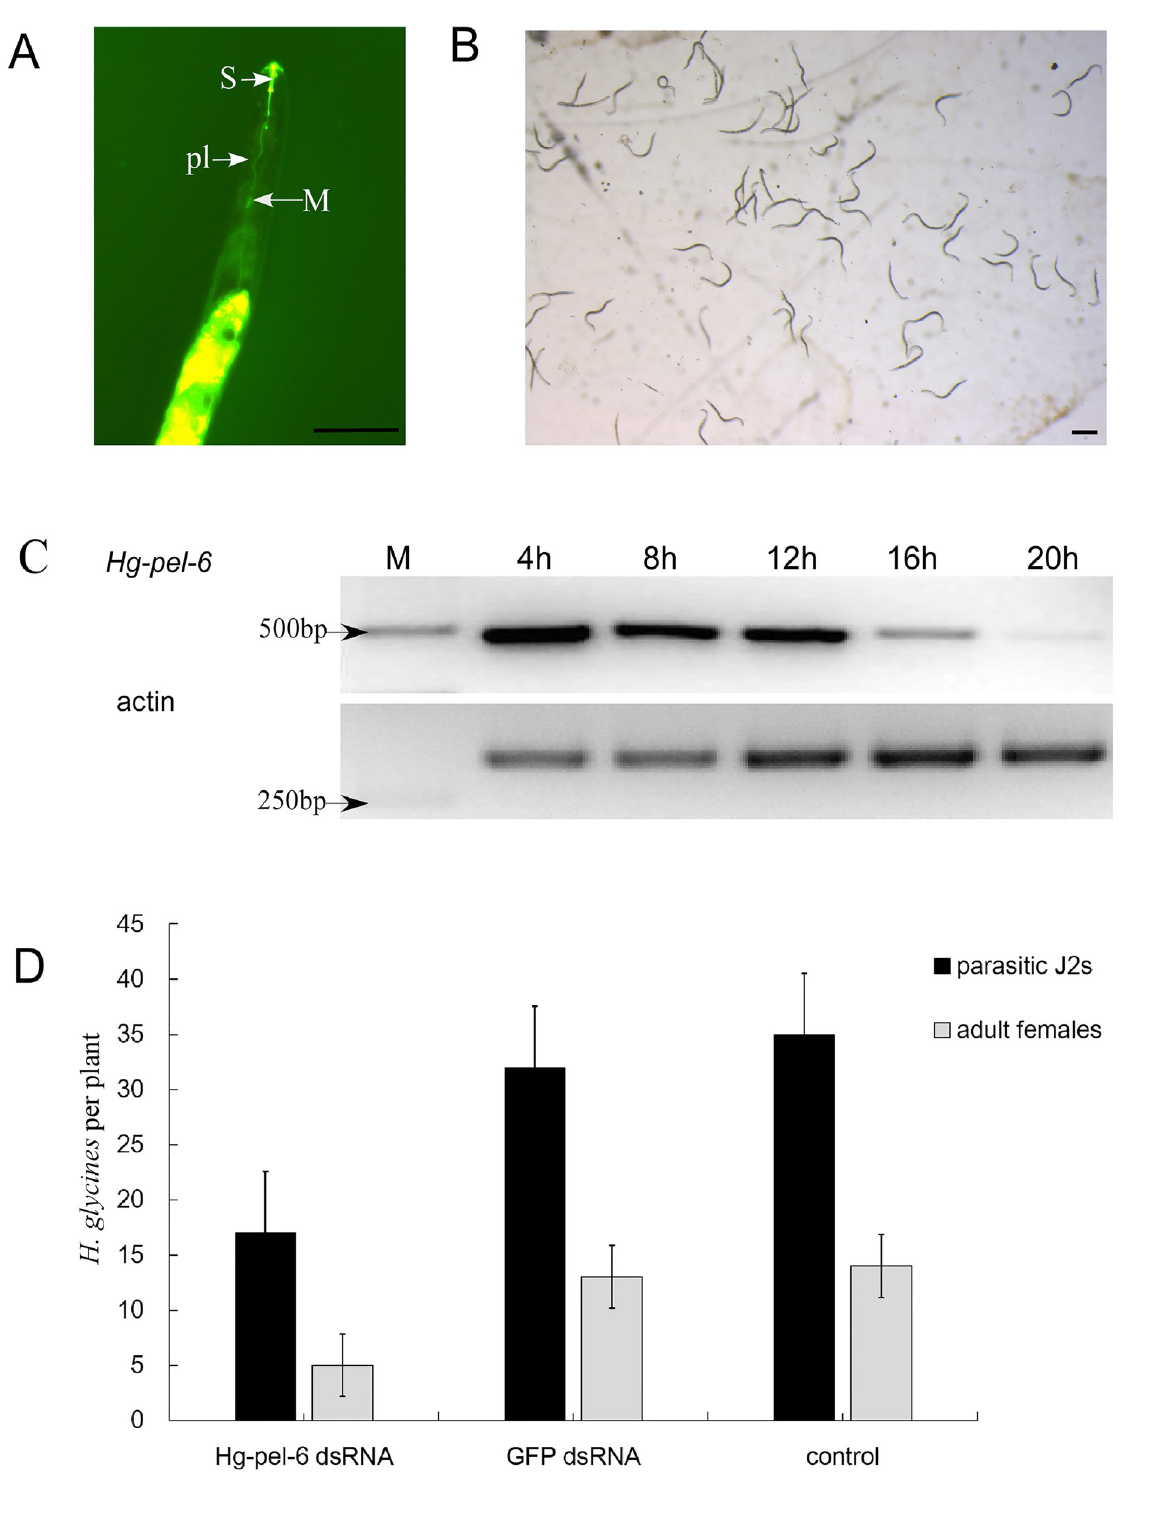
Fig 6. RNAi uptake of Heterodera glycines and infections of soybean roots with nematodes following the Hg-pel-6 dsRNA treatment. The fluorescein isothiocyanate (FITC) uptake was observed by fluorescence microscopy (A), and the activity of the nematodes after soaking was observed under a light microscope (B). S, stylet; M, median bulb; pl, pharyngeal lumen. Scale bar: 50 μ m. (C) An RT-PCR analysis for the expressions of Hg-pel-6 and actin